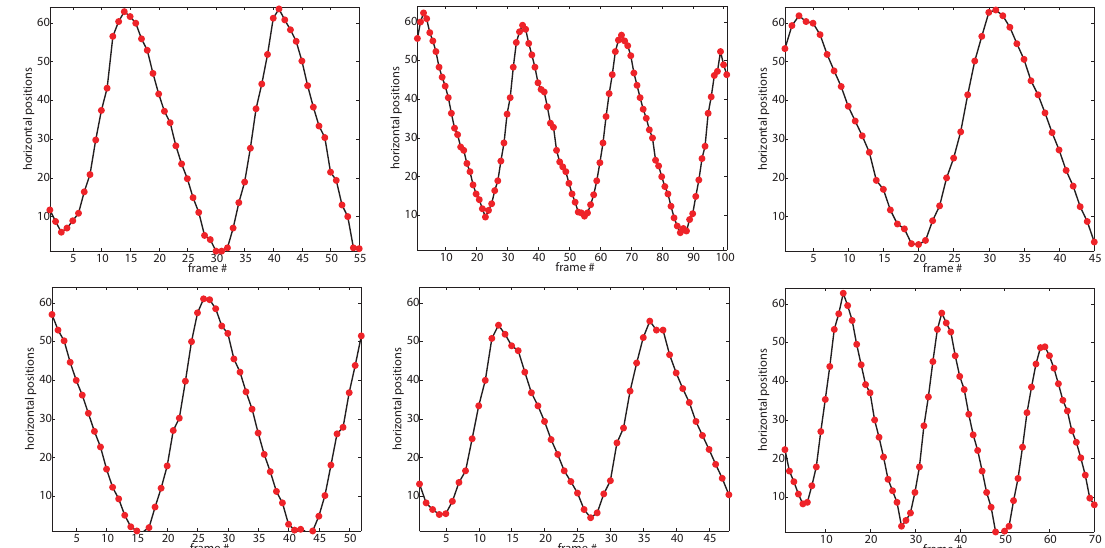
Figure 4. Illustration of motion information of feet with some examples on the iLIDS-VID dataset. We annotate the mean horizontal positions of the right foot of a person’s image sequence, and then we show the horizontal positions (red dots) with frame